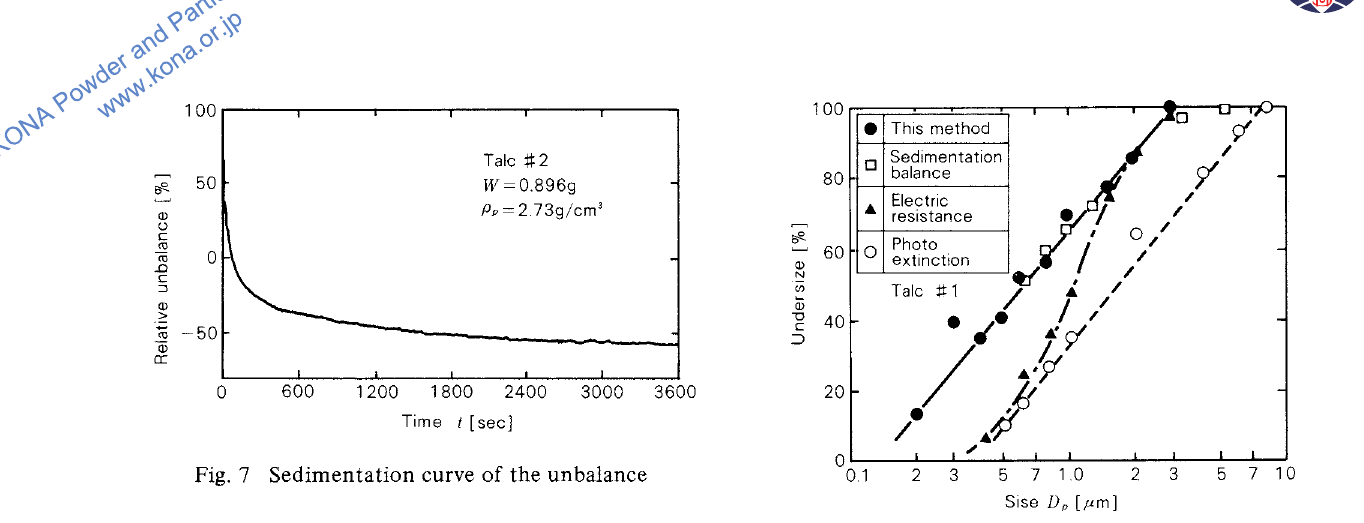
Fig. 7 Sedimentation curve of the unbalance - Linear acceleration and constant rotation of 2500 r.p.m. shown in Fig. 3.